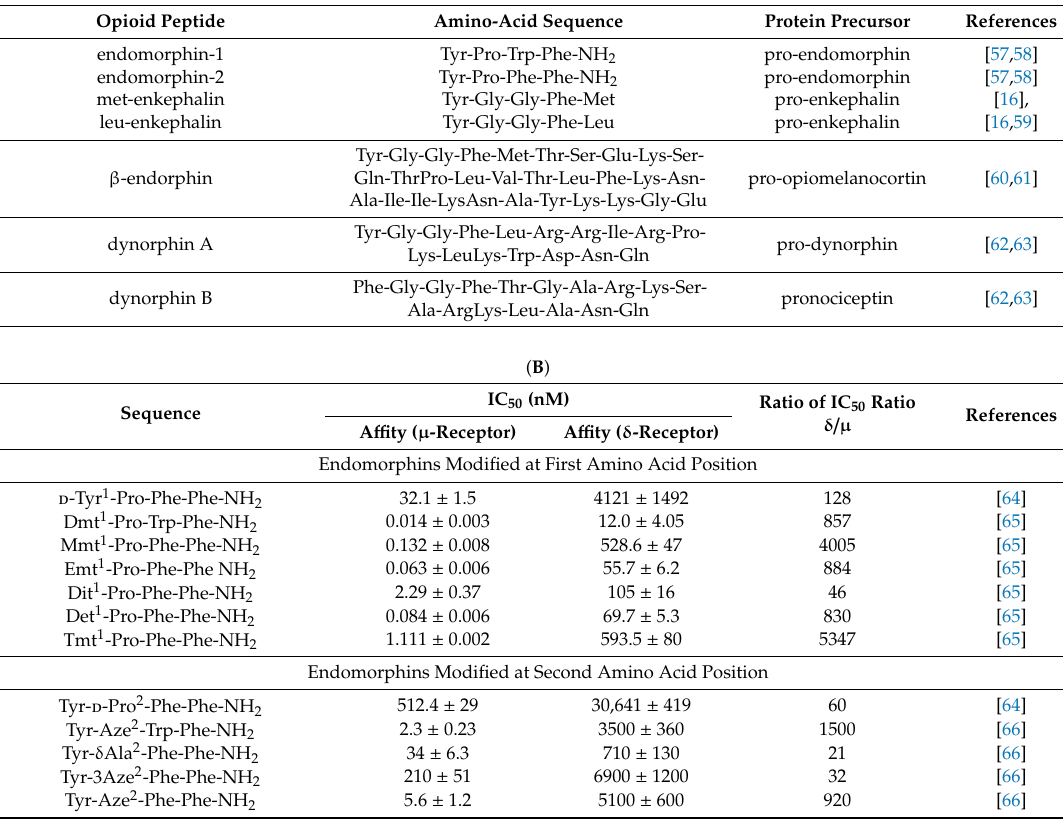
Table 2. ( A ) Endogenous opioid peptides. ( B ) Binding a ffi nities of various Endomorphin